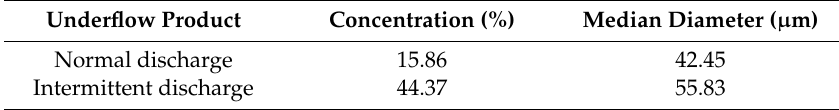
Table 4. Comparison of underflow